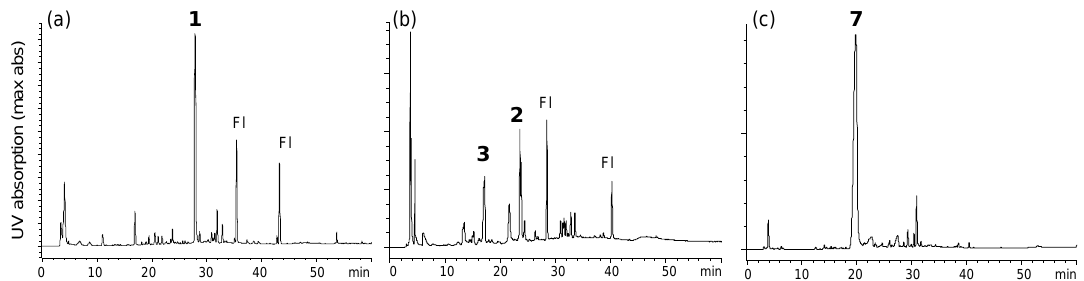
Figure 1. HPLC profiles of 60% CH 3 CN extracts of ( a ) Persicaria capitata , ( b ) Persicaria chinensis and ( c ) Polygonum runcinatum var. sinense. 1 : davidiin, 2 : geraniin, 3 : persicarianin, 7 : granatin A and Fl: flavonoid glycosides.